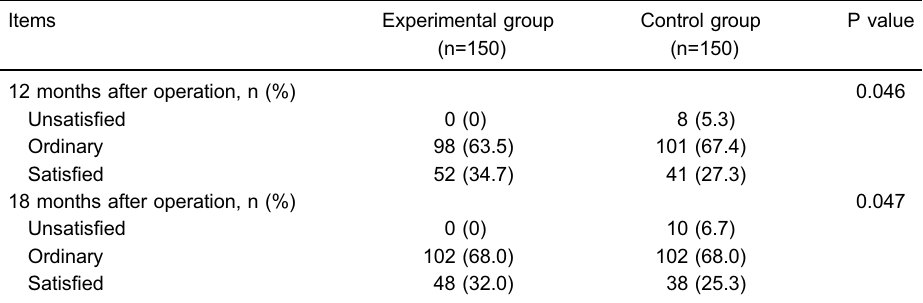
Table 3. Comparison of postoperative patient satisfaction between the two groups.